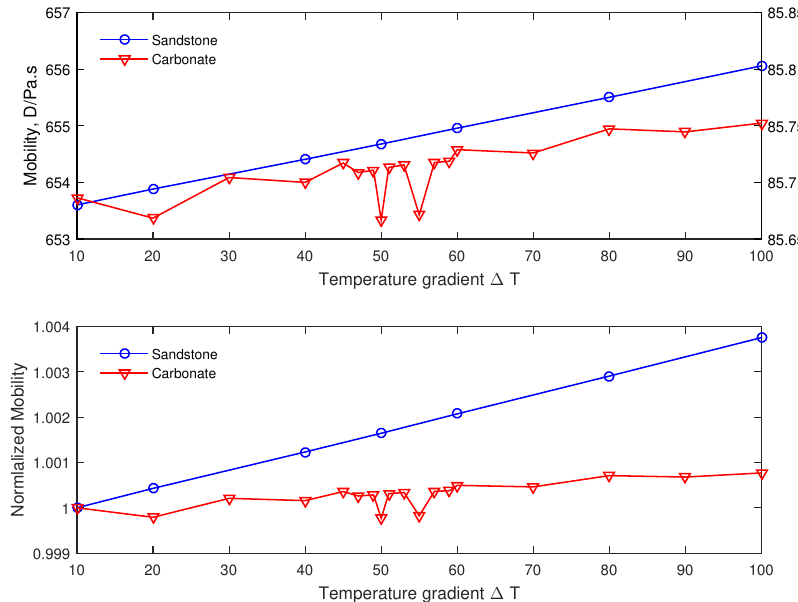
Figure 9. Variation of the effective mobility based on the temperature gradient imposed on the pore-scale model for the Fontainebleau sandstone and Grosmont carbonate.